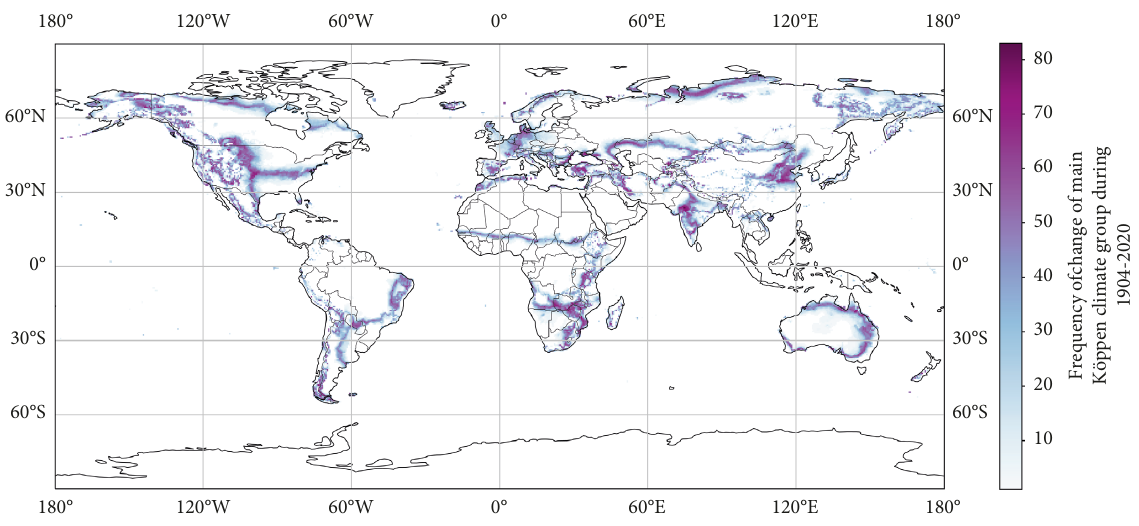
Figure 4: Frequency of the interannual change of the main K¨oppen climate class in